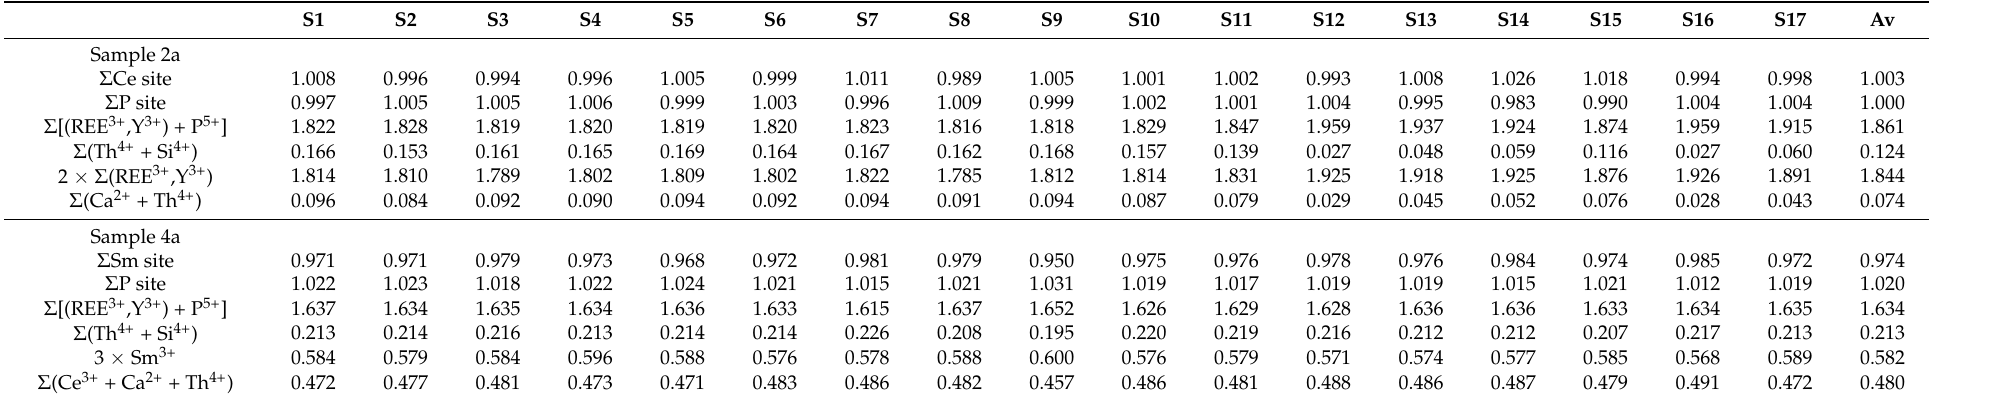
Table 4. Summary of chemical composition ( apfu ) from 17 EPMA spots for samples 2a and 4a.